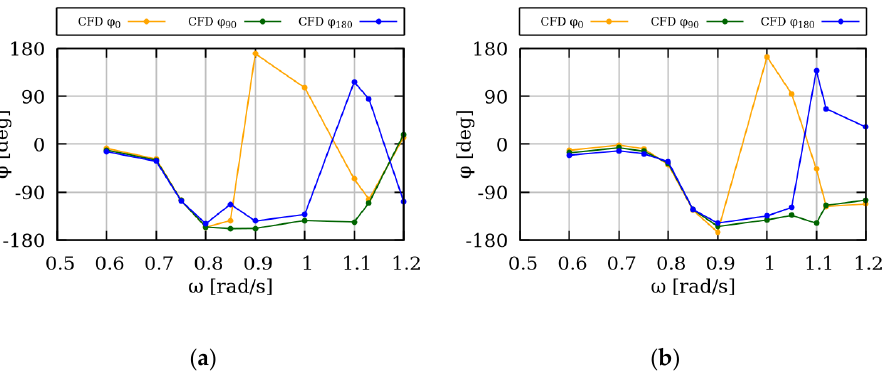
Figure 15. Analysis of the phase angle of the downwind (0 deg), middle (90 deg) and the upwind (180 deg) wave gauges for the two configurations. The position of the gauges is shown in Figure 13a; ( a ) Configuration 1; ( b ) Configuration 2.